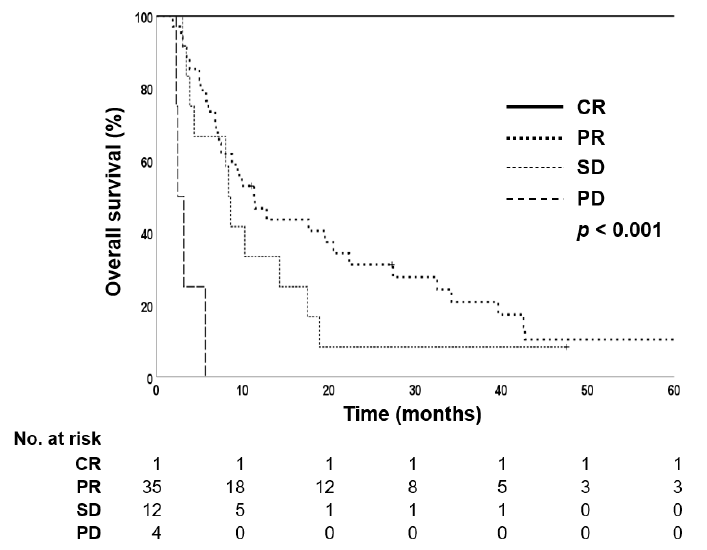
Figure 3. Kaplan–Meier estimates of overall survival in liver-directed concurrent chemoradiotherapy-treated group according to treatment response.